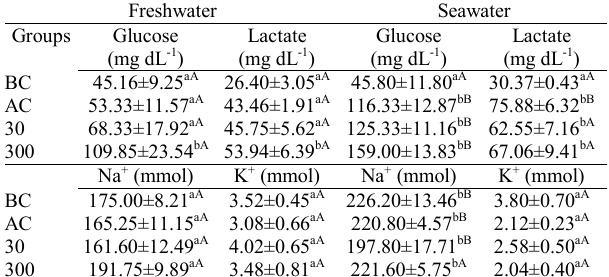
Table 3. Plasma glucose, lactate, Na + and K + levels in fat snook Centropomus parallelus acclimated to fresh- or seawater and exposed for 10 min to the essential oil from old leaves of Nectandra megapotamica (30 and 300 µL L -1 ). BC: basal control; AC: aquarium control. Data presented as means ± SEM ( n = 6). Different lower case letters indicate significant difference between groups in the same salinity, while capital letters indicate significant difference between salinities in the same